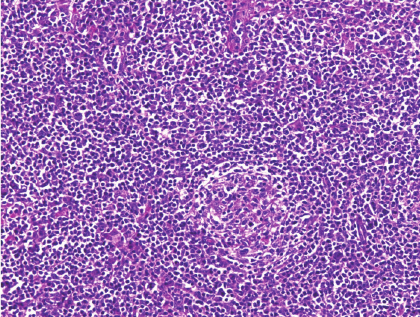
Figure 4: Plasmacytic cell and Hodgkin cell lymphoma. Section of lymph node biopsy, × 100 magnification.